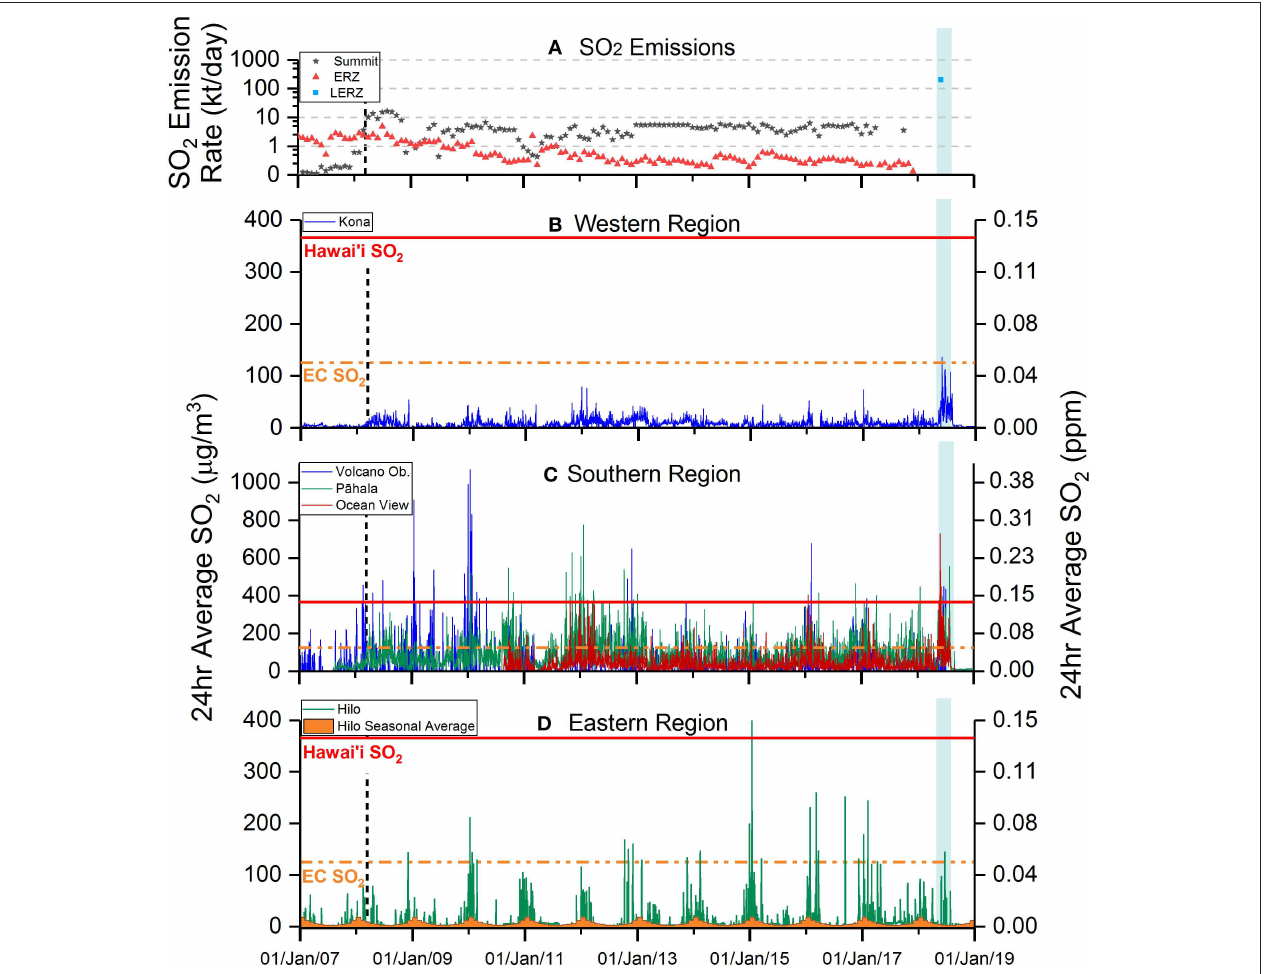
FIGURE 2 | SO 2 mass concentrations relative to health guidelines in selected populated areas of Island of Hawai’i. (A) SO 2 emissions from K ¯ ılauea summit indicated with black stars; from ERZ indicated with red triangles; from 2018 LERZ eruption indicated with blue square. Note logarithmic scale. (B–D) SO 2 air quality (24-h mean) in communities from 2007 to the end of 2018. Solid red line: Hawai’i Standard air quality threshold (24-h mean of 366 µ g/m 3 ); dashed orange line: European Commission (EC) air quality threshold (24-h mean of 125 µ g/m 3 ). Dashed black line: 2008 initiation of summit activity; blue highlight: 2018 LERZ eruption duration. (A) SO 2 emissions data sourced from Elias and Sutton (2012), Beirle et al. (2014), Elias et al. (2018), and Elias et al. (in preparation). Summit emissions for 2008–2012 are from Beirle et al. (2014). LERZ data-point represents the average SO 2 emission from the LERZ eruption for June 2018, taken from Kern et al. (2019). (B) Note that “Volcano Ob.” stands for Volcano Observatory; (D) seasonal average for Hilo between 2007 and 2017 indicated by orange